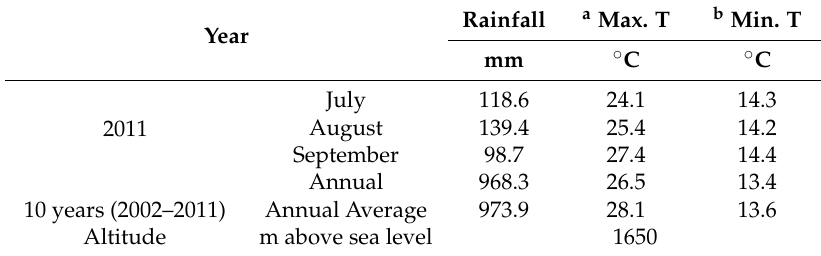
Table 1. Average rainfall, maximum and minimum temperature during the 2011 growing season, annual and long-term average (2002–2011) at Halaba, nearby metrological station of the study area.